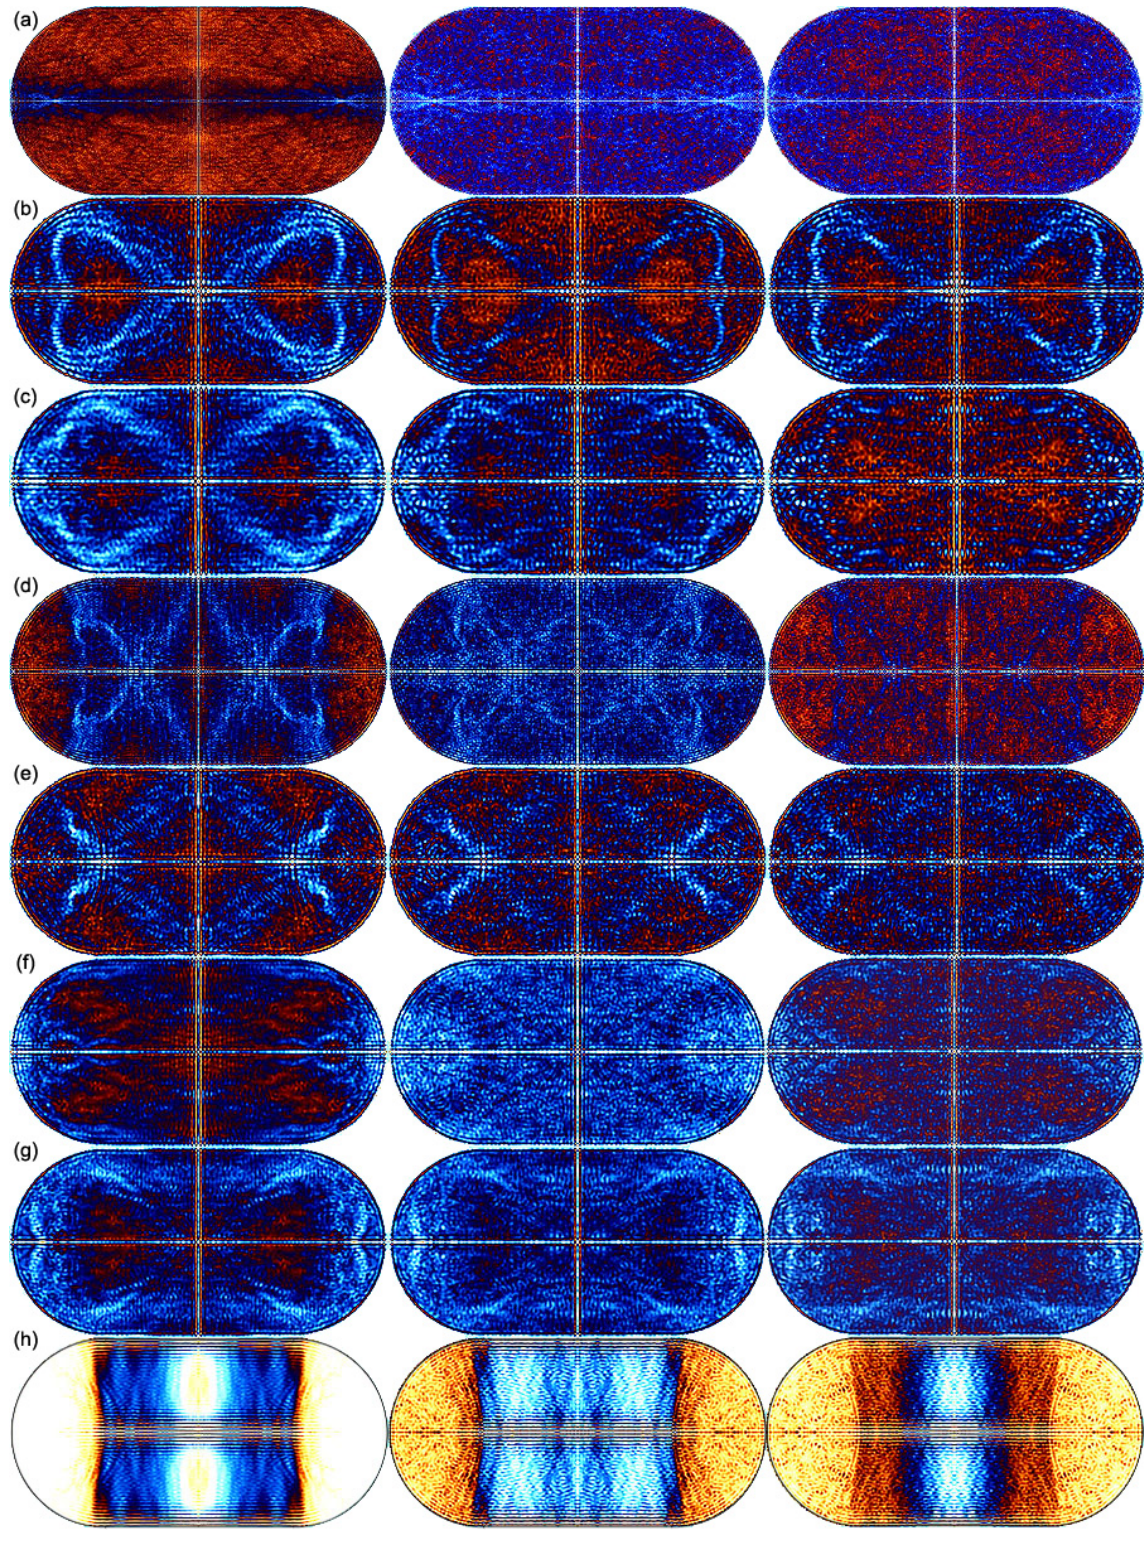
Figure 6: A more detailed long-term evolution of scarring of a wave packet with twice the frequency and half the Gaussian variance for the same sequence of orbits as in Figure 3, superimposing stages: 0-3300, 3300-6600, 6600-9900, 9900-13200 for (f) and (g). The long-term evolution suggests that the systems are converging to a linear combination of the principal orbits due to the initial waveform exciting more than one orbital solution. Hence (b) and (e), being two of the strongest orbits, retain their excitation almost unchanged through 9900 iterations, while for example (g) already shows features of (b) in its initial